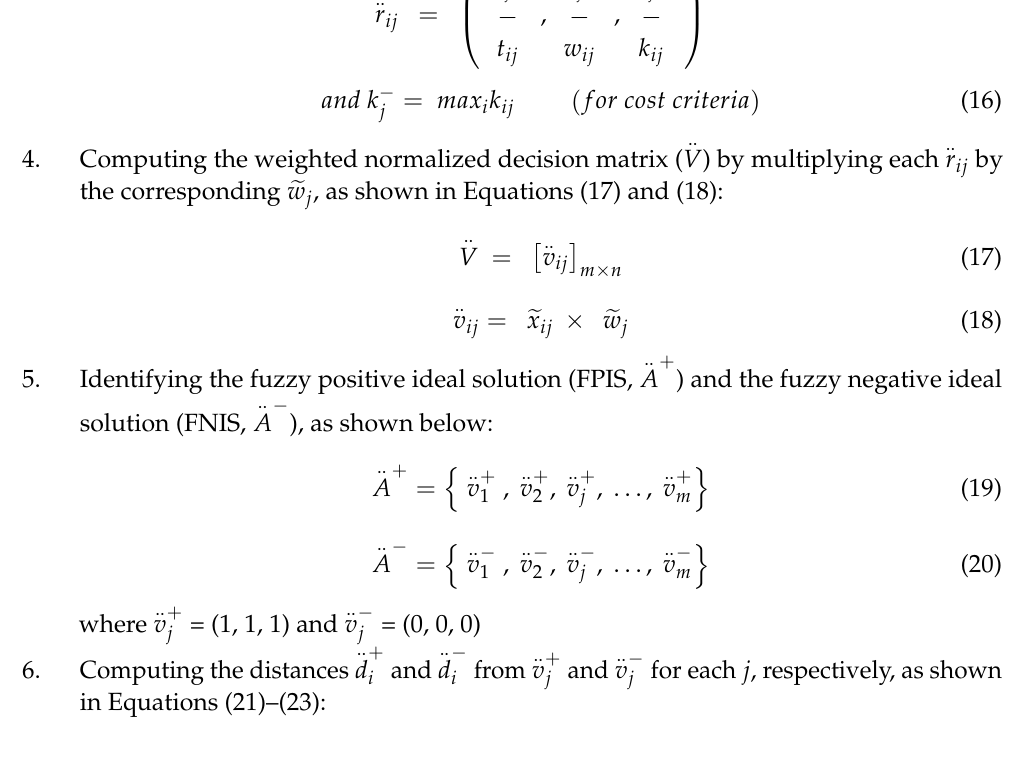
.. .. + − v v and for each j , respectively, as shown j j